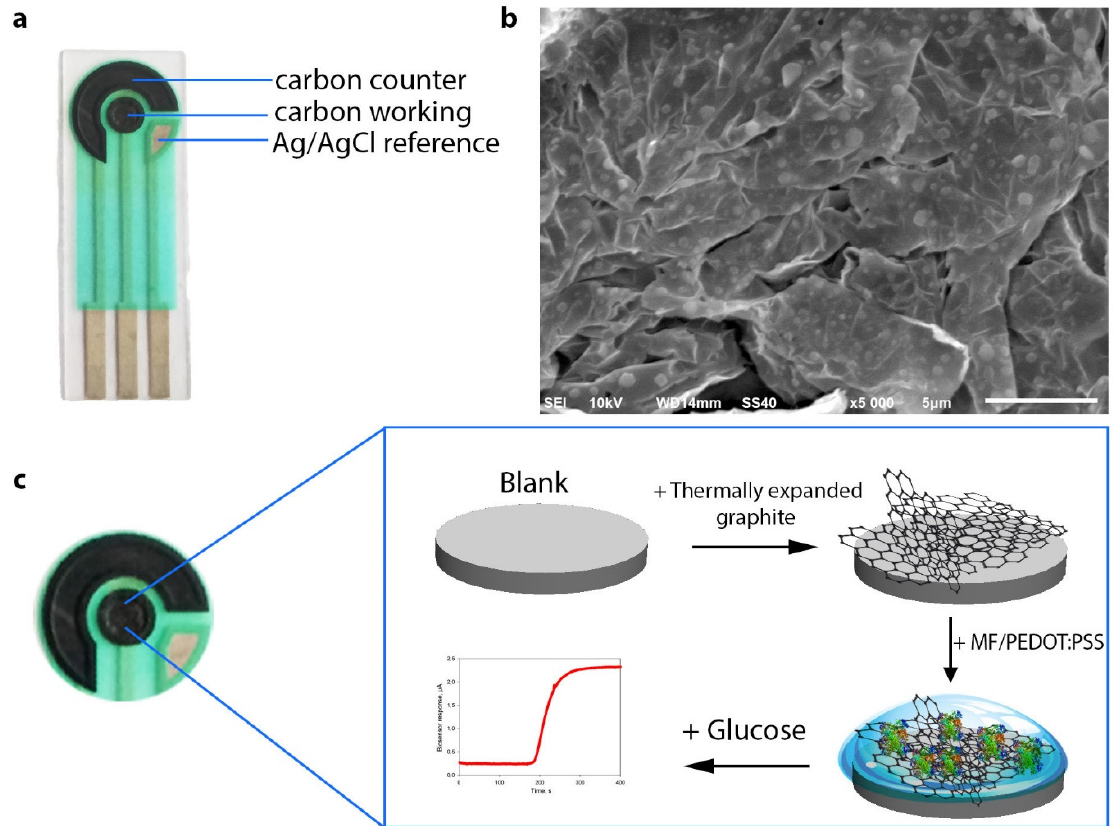
Figure 1. ( a ) Schematic of a graphite screen-printed electrode featuring counter, reference and working electrodes. ( b ) SEM image of thermally expanded graphite. ( c ) Schematic of the formation of a composite on the surface of the biosensor’s working electrode and its operating principle.